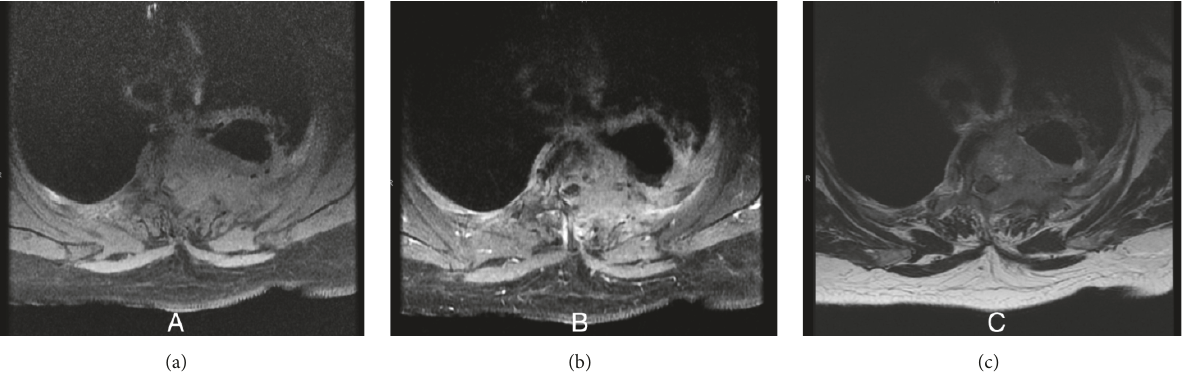
Figure 2: Magnetic resonance imaging (MRI) of the thoracic spine in the axial plane with (a) T1-weighted sequence without contrast, (b) T1-weighted sequence with contrast, and (c) T2-weighted sequence.